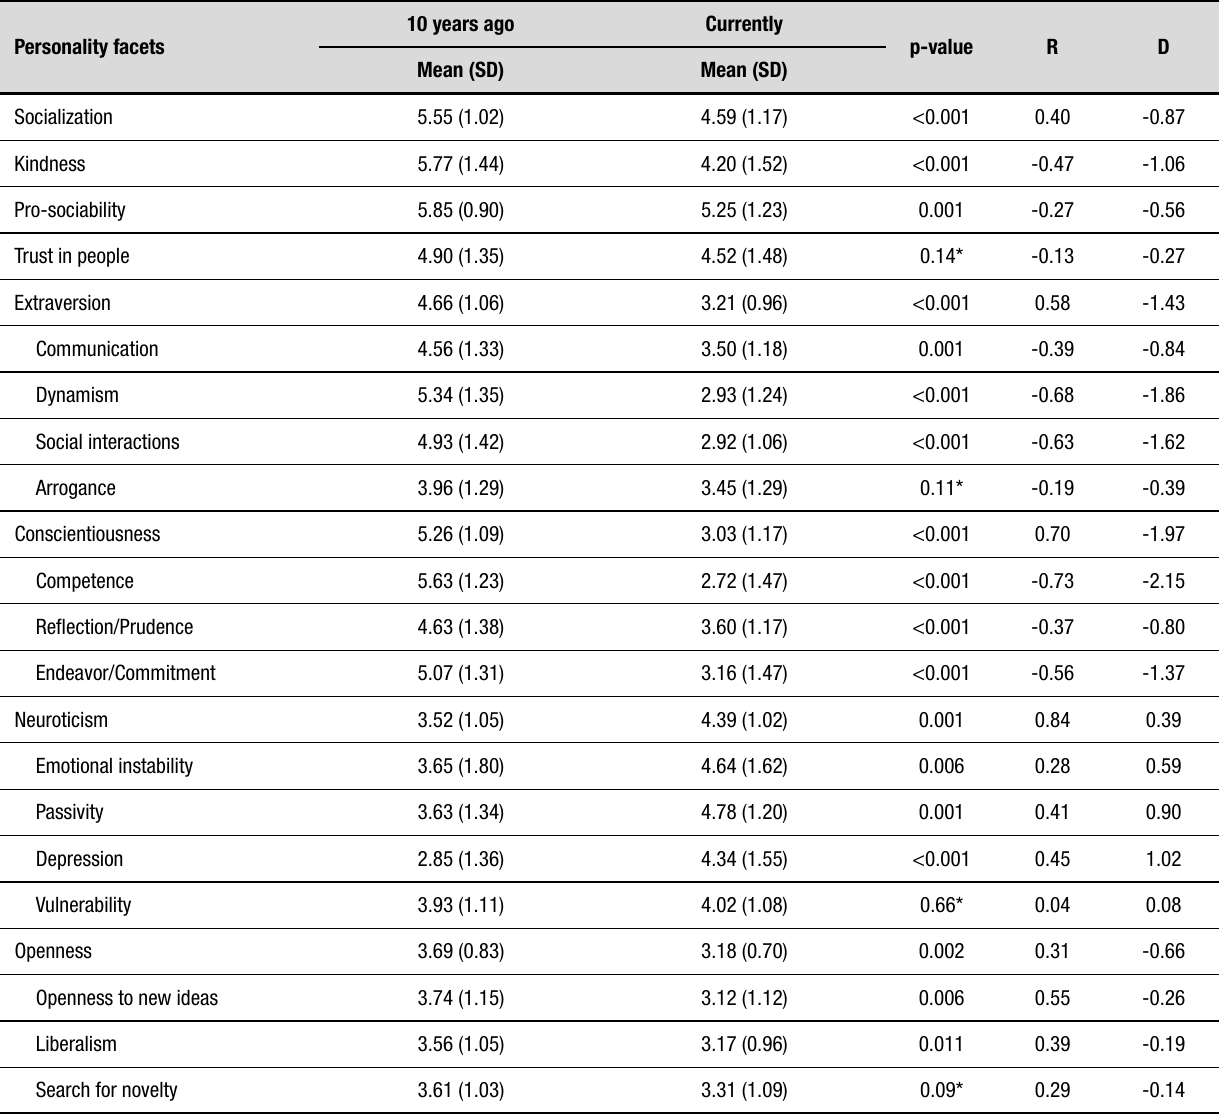
Table 2. Comparison between premorbid and current personality factors.